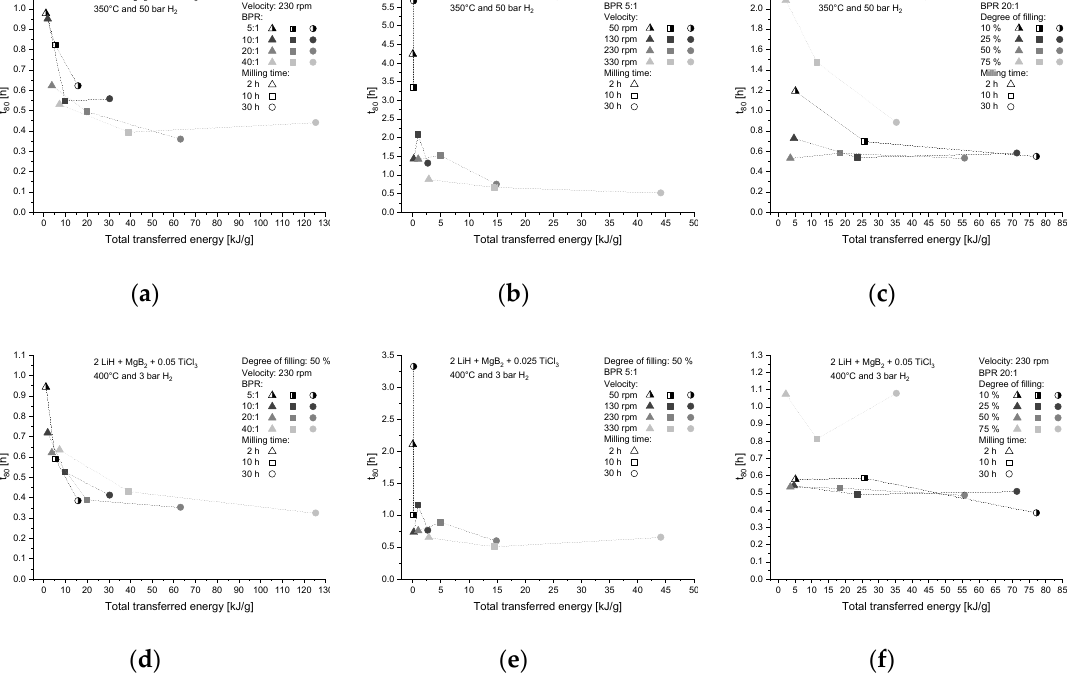
Figure 4. First row: absorption kinetic behavior as a function of the energy transfer for different ( a ) BPRs, ( b ) milling velocities and ( c ) degree of filling, as well as for different milling times. Second row: graphs related to desorption t 80 varying ( d ) BPRs, ( e ) milling velocities and ( f ) degree of filling.